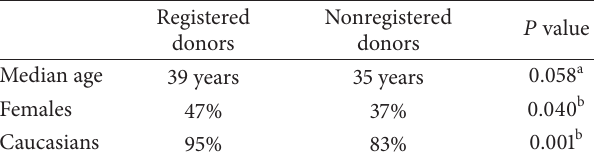
Table 4: Difference between registered and nonregistered